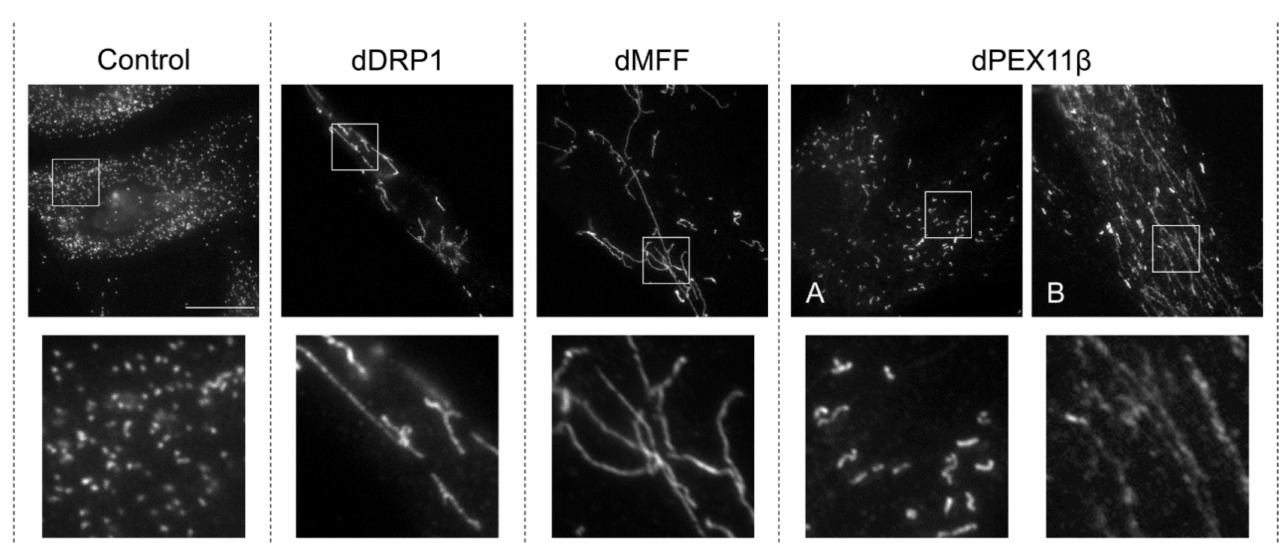
Figure 3. Peroxisome morphology in DRP1, MFF, and PEX11 β -deficient patient fibroblasts. Cultured patient skin fibroblasts were processed for immunofluorescence and stained with antibodies to PEX14, a peroxisomal membrane marker. Note the hyper-elongated peroxisomes in DRP1 and MFF-deficient cells (dDRP1, dMFF). In contrast to dMFF cells, peroxisomes in dDRP1 cells are able to constrict. Peroxisomes in PEX11 β -deficient fibroblasts (dPEX11 β ) are mainly rod-shaped (A). Note that PEX14 is often mistargeted to mitochondria in dPEX11 β cells (B). Peroxisomes in ACBD5-deficient patient fibroblasts (not shown) are indistinguishable from controls. Higher magnifications of boxed regions are shown. Scale bar, 20 µ